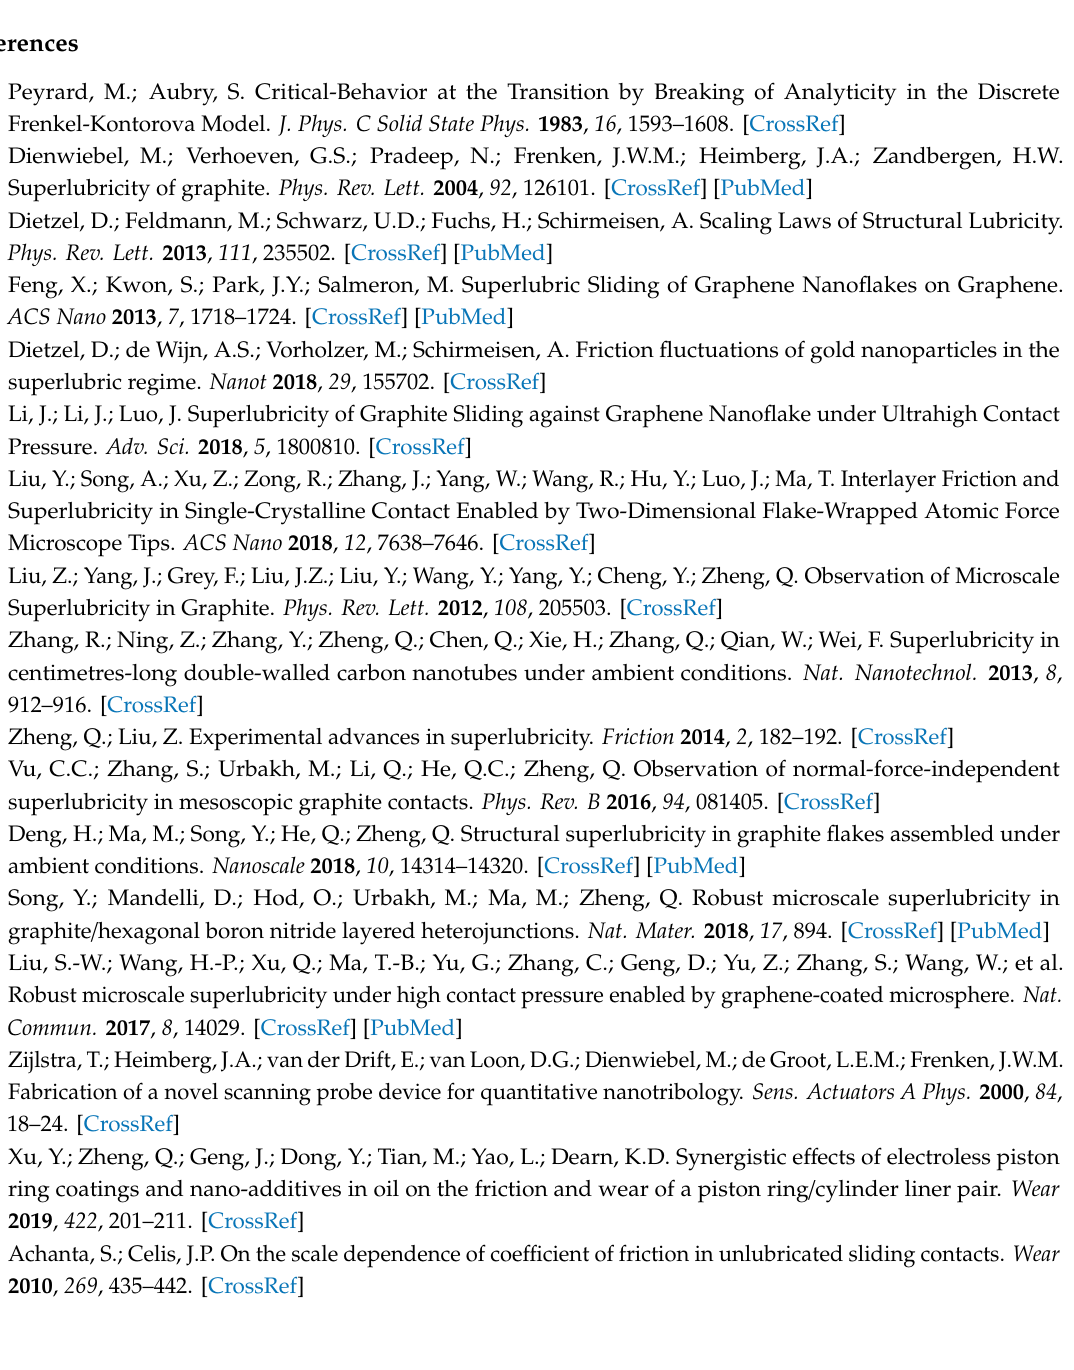
Experiment curves. S6: More friction experiments: Figure S7: Friction loops of the graphite-graphene interface using the #2 teeter-totter beam, Figure S8: Friction experiments of the graphite-mica and graphite-graphene interfaces with #5 teeter-totter